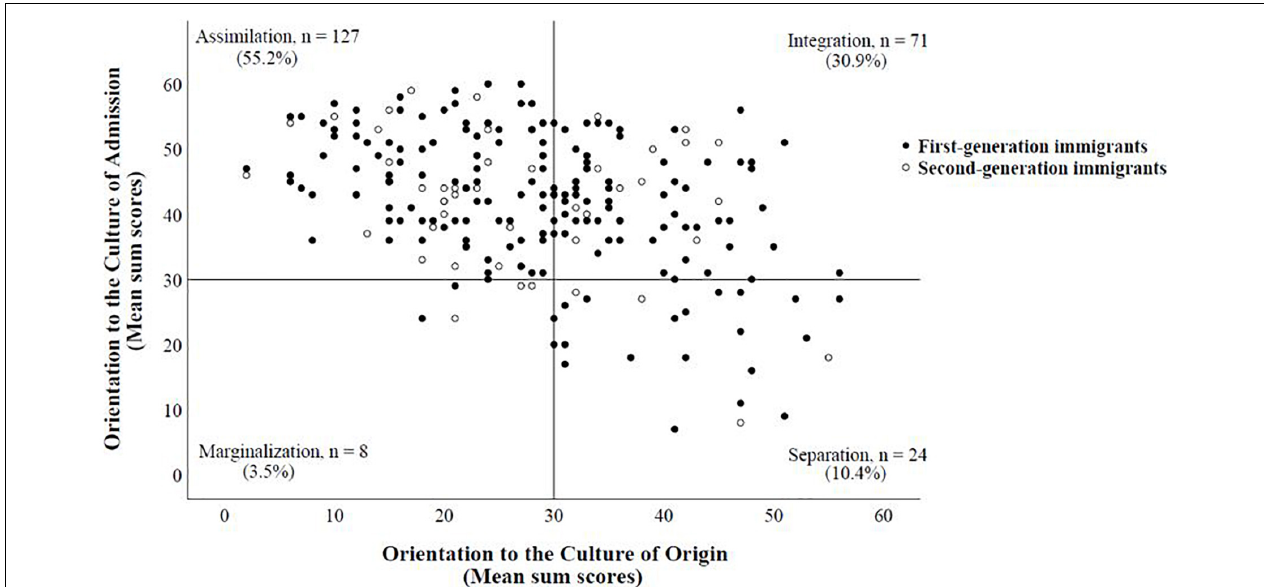
FIGURE 2 | Distribution of acculturation strategies among forensic psychiatric patients with a migration background ( N = 230 1 ). 1 Missing values: n = 5. Every dot represents the mean sum score of one patient, and the reference lines represent the center of the subscales on the Frankfurter Acculturation Scale (FRACC). The distance between a dot and the reference line reflects the strength of the respective acculturation strategy, i.e., the greater the distance, the stronger the respective acculturation strategy. TABLE 2 | Differences in duration of hospital stay, years in Germany, age and quotient of years in Germany/age between patients with different acculturation strategies (marginalization, separation, integration, and assimilation). Marginalization Separation Integration Assimiliation Statistics M ( SD ) M ( SD ) M ( SD ) M ( SD ) Kruskal–Wallis- H df =